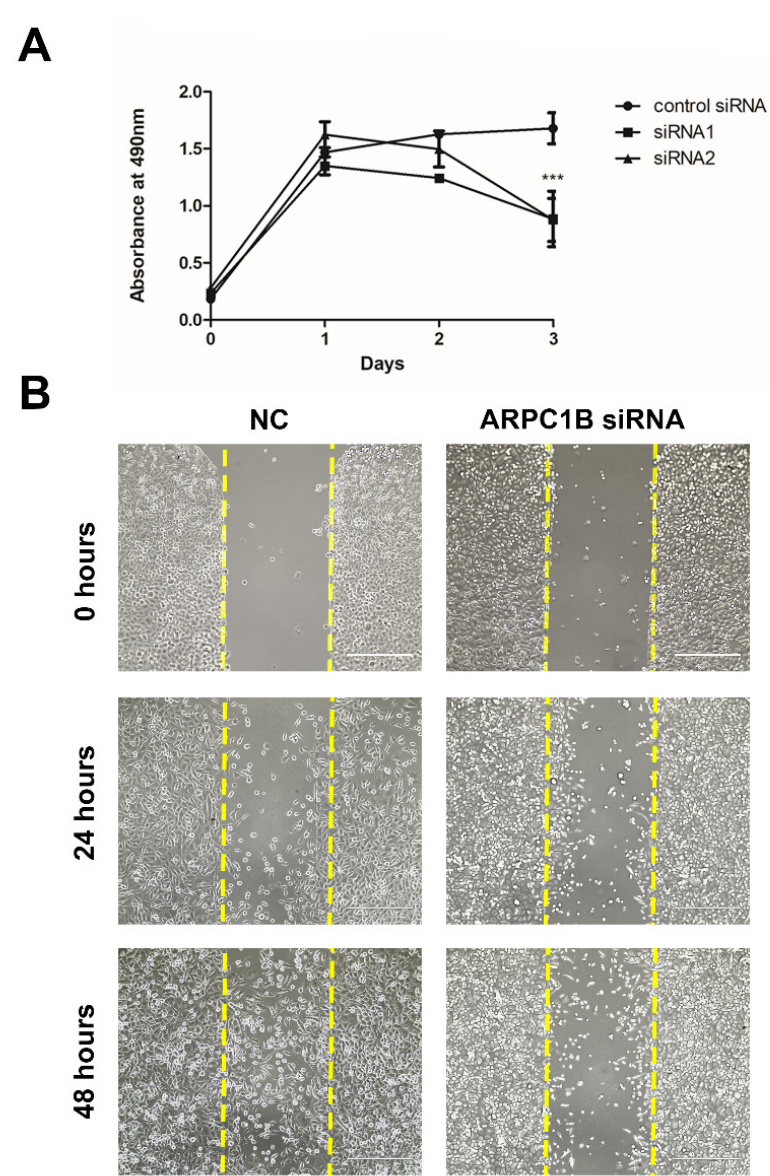
Figure 5. Knockdown of ARPC1B in PC3 cell line attenuates PCa cell proliferation and migration. ( A ) Relative PC3 cells proliferation using MTS assay over three days. Statistical significance calculated using, two-way ANOVA, *** shows p < 0.001. Error bars indicate the SEM. ( B ) wound healing assay for PC3 cells after ARPC1B knockdown at 0, 24, and 48 h.